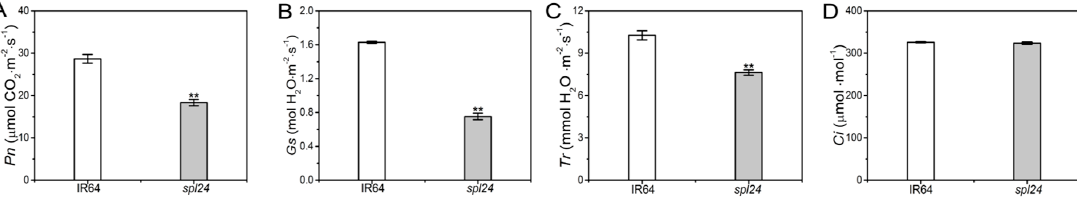
Figure 2. Photosynthetic parameters of leaves at the heading stage. (A) Net photosynthetic rate ( Pn ); (B) stomatal conductance ( Gs ); (C) transpiration rate ( Tr ); (D) intercellular CO 2 concentration ( Ci ). Values are means ± SD ( n = 3); ** indicates significance at p ≤ 0.01 by Student’s t test.